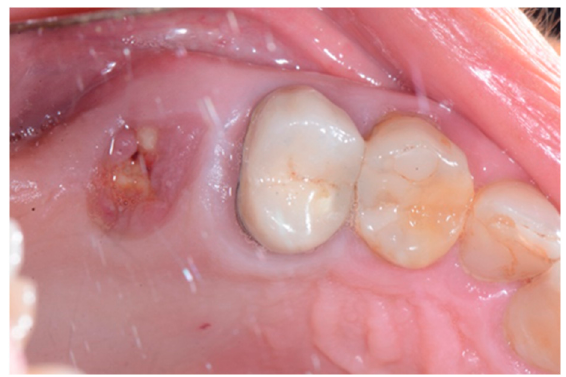
Figure 2. Clinical situation after crown removal.